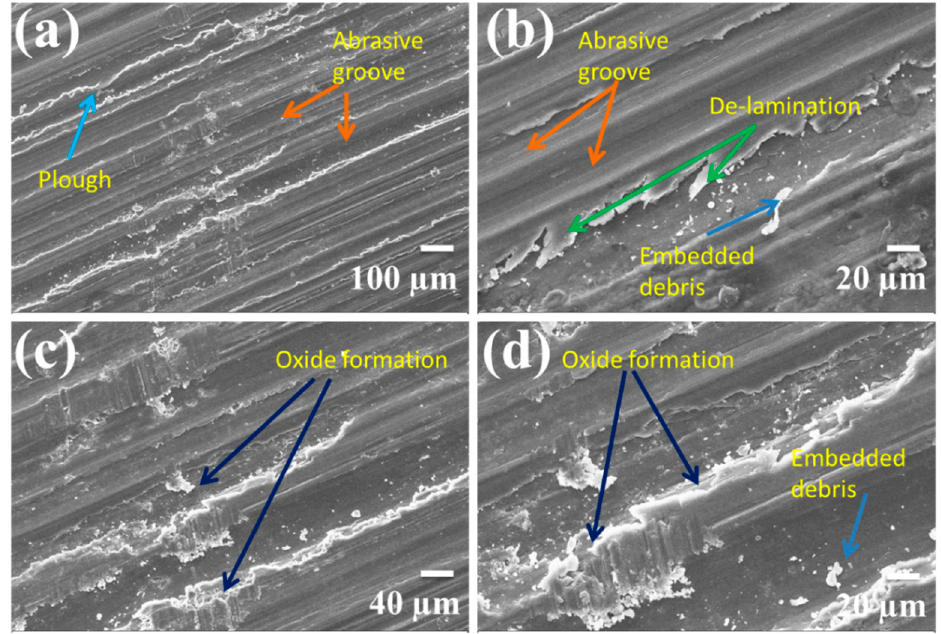
Figure 7. SEM micrographs of the worn surfaces of AZ91 magnesium alloy: ( a ) 19.24 N, 1.39 m/s; ( b ) 39.62 N, 2.6 m/s; ( c ) 19.24 N, 1.39 m/s; ( d ) 39.24 N, 2.6 m/s.